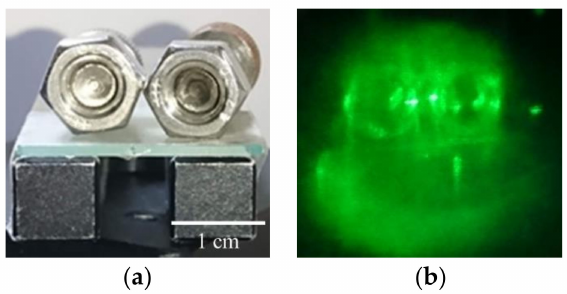
Figure 6. ( a ) The appearance of the metal nuts, and ( b ) the reconstructed 3D image from the EGPEA-based